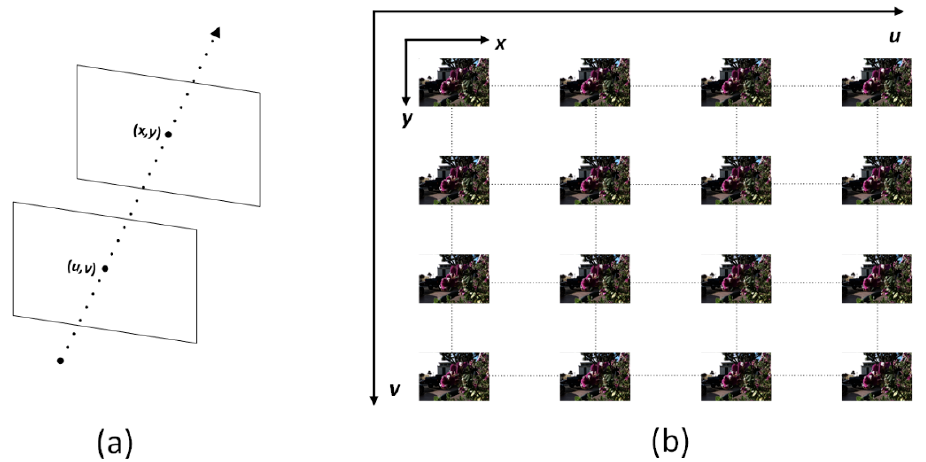
Figure 1. ( a ) The 4D LF representation with two planes’ intersections of light rays. ( b ) LF images.